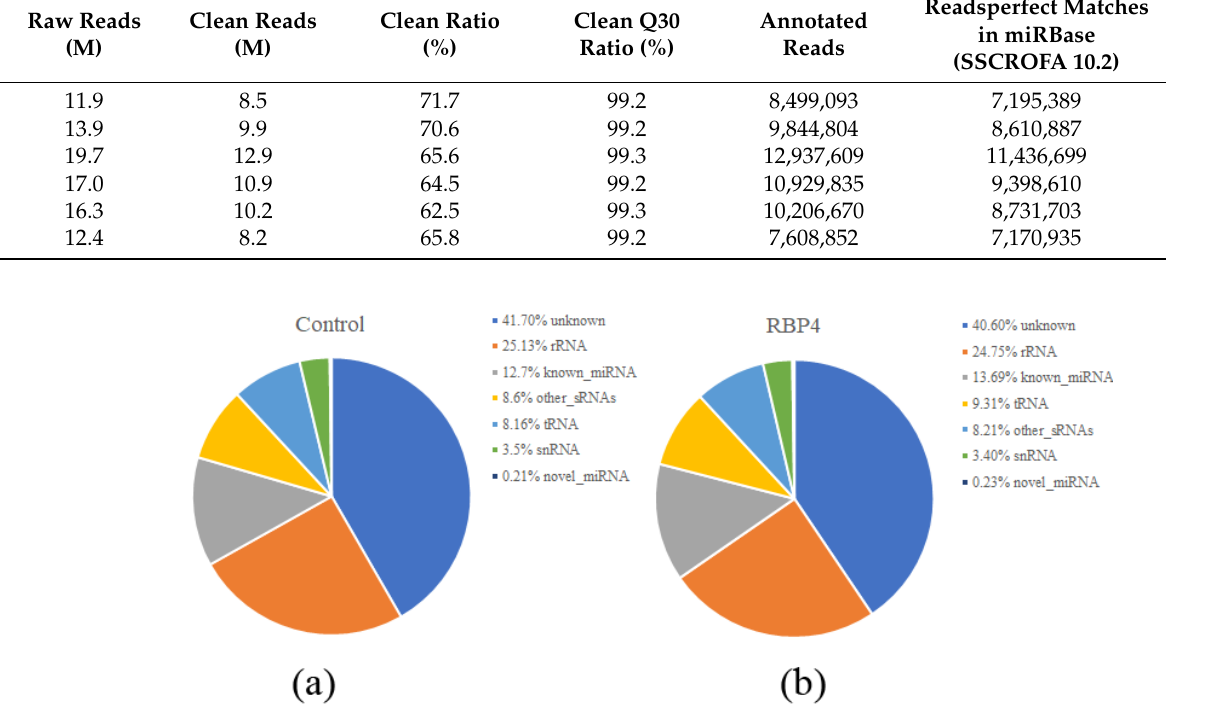
Table 1. Statistical analysis of sequencing data from the control group and RBP4 treatment group.